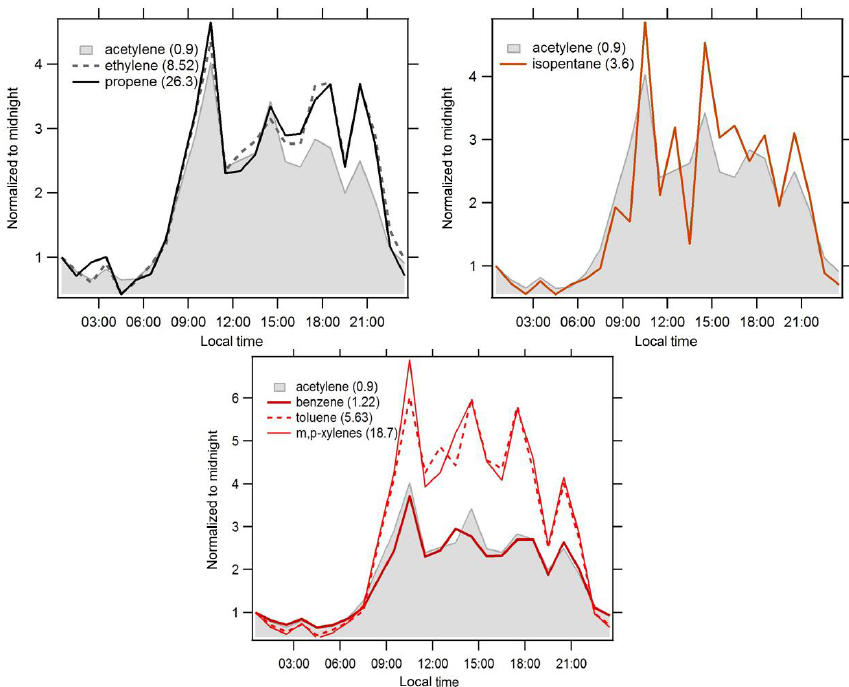
Figure 3. Normalized diurnal profiles of the mixing ratios of selected species to midnight values in winter. Numbers in parentheses are the rate coefficient with OH × 10 − 12 cm 3 molecule − 1 s − 1 (Atkinson and Arey, 2003; Atkinson,